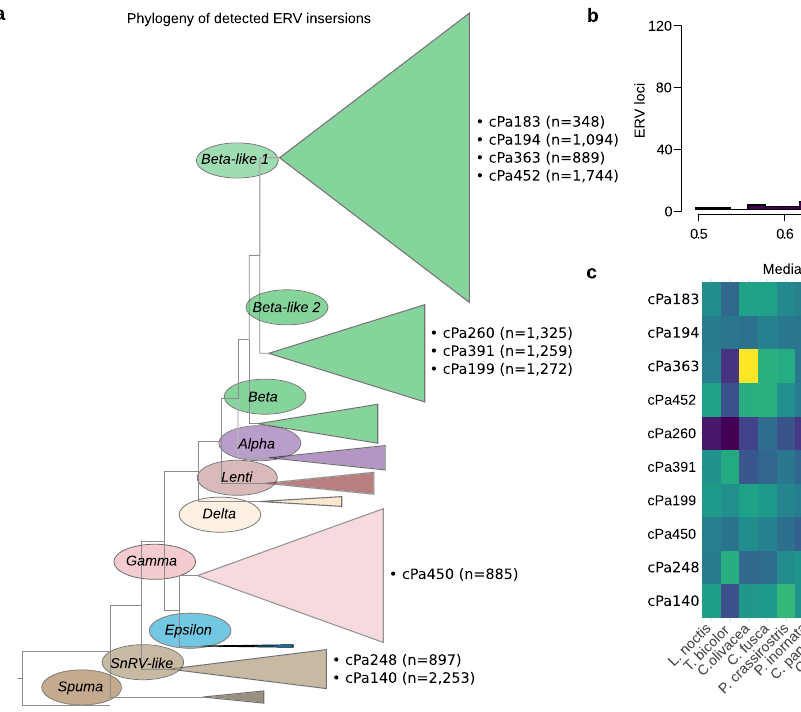
of ERVsatlocithatcontainatleastoneERVidenti fi cationinallspecies.Locithat fi t this criterion are assumed to pre-date Darwin ’ s fi nch speciation and are therefore expected to be fi xed in all populations. Observed frequencies <1.0 of these ERVs, can be assumed to be the result of false-negative identi fi cation calls. c Heatmap showing varying ERV MIR in different, but closely related, host